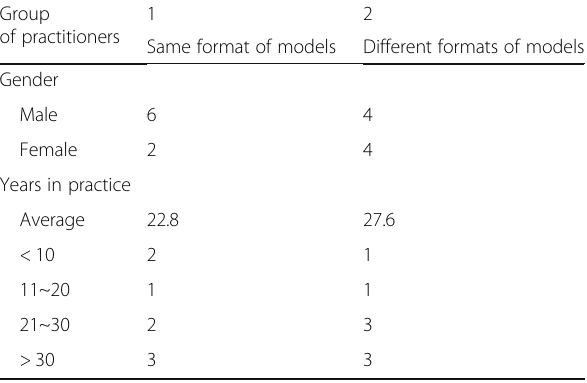
Table 1 The demographic characteristics of the orthodontists Group 1 of practitioners Same format of models Different formats of